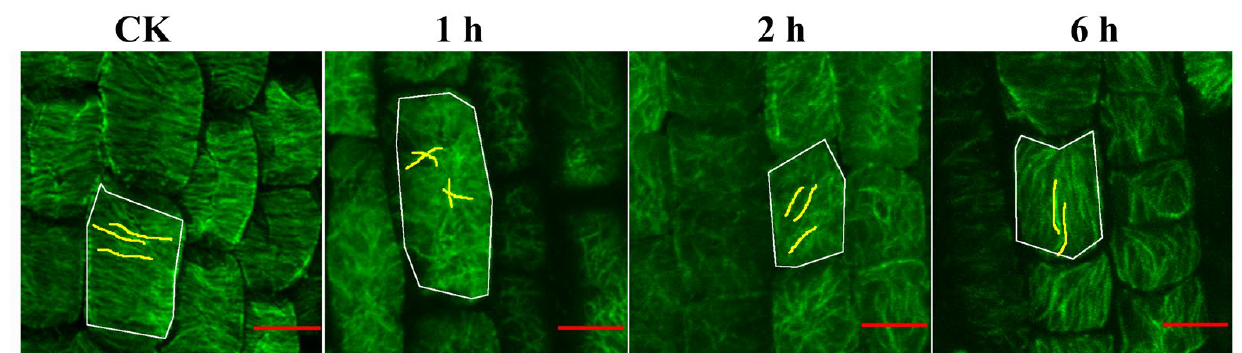
Figure 3. Time series images of the cortical microtubules in root epidermal cells of six-day-old seedlings at 1 h, 2 h, and 6 h post-radiation by UV-B for 30 min in A. thaliana wild type (Col-0). Cortical microtubules in root cells of seedlings that did not undergo UV-B radiation were used as controls (CK). The yellow lines processed by software Image J represent the change of length, direction, and structure of the microtubules in the selected cells. Immunofluorescence images were collected using a Zeiss LSM 510 META confocal microscope. Each experimental group had at least 10 seedlings, and each experiment was repeated three times. Scale bars represent 10 μm.